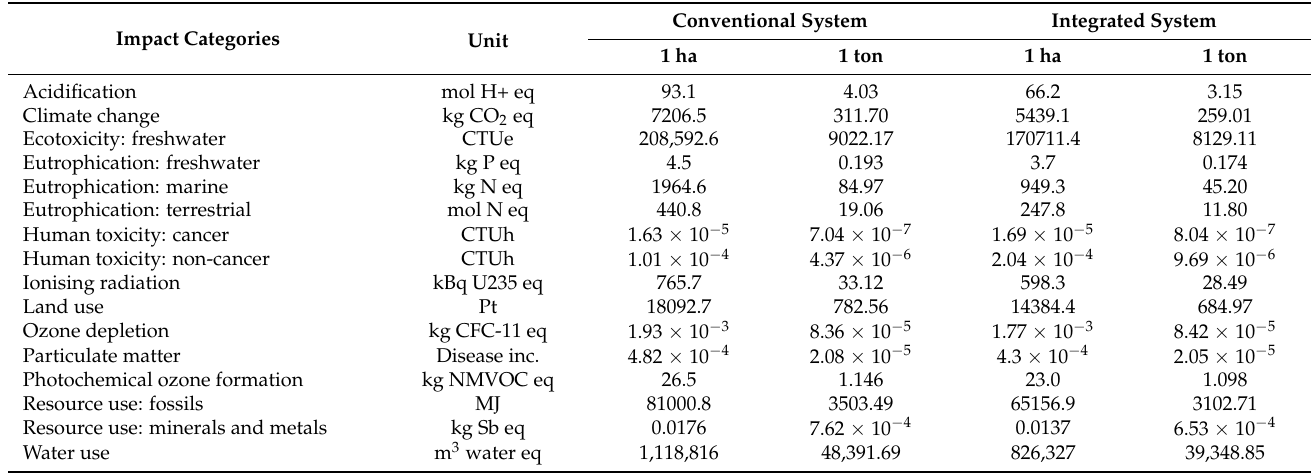
Table A2. Midpoint characterized results in absolute values per 1 ha of cultivated and 1 ton of table grapes at the farm gate with conventional (groundwater) and integrated (groundwater + reclaimed water) irrigation.